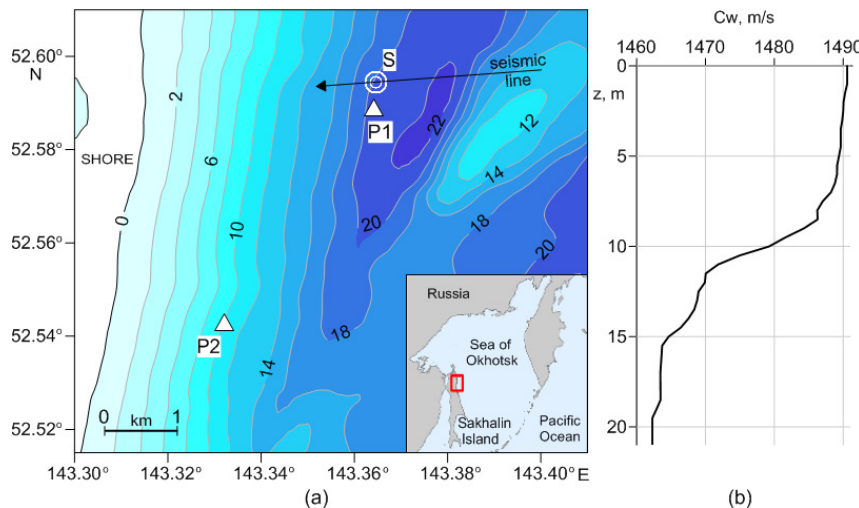
Figure 1. Map of the seismic survey area with indication of one of the sound emission point S and two reception points P1 and P2 ( a ). The measured sound speed profile inside the water layer ( b ).